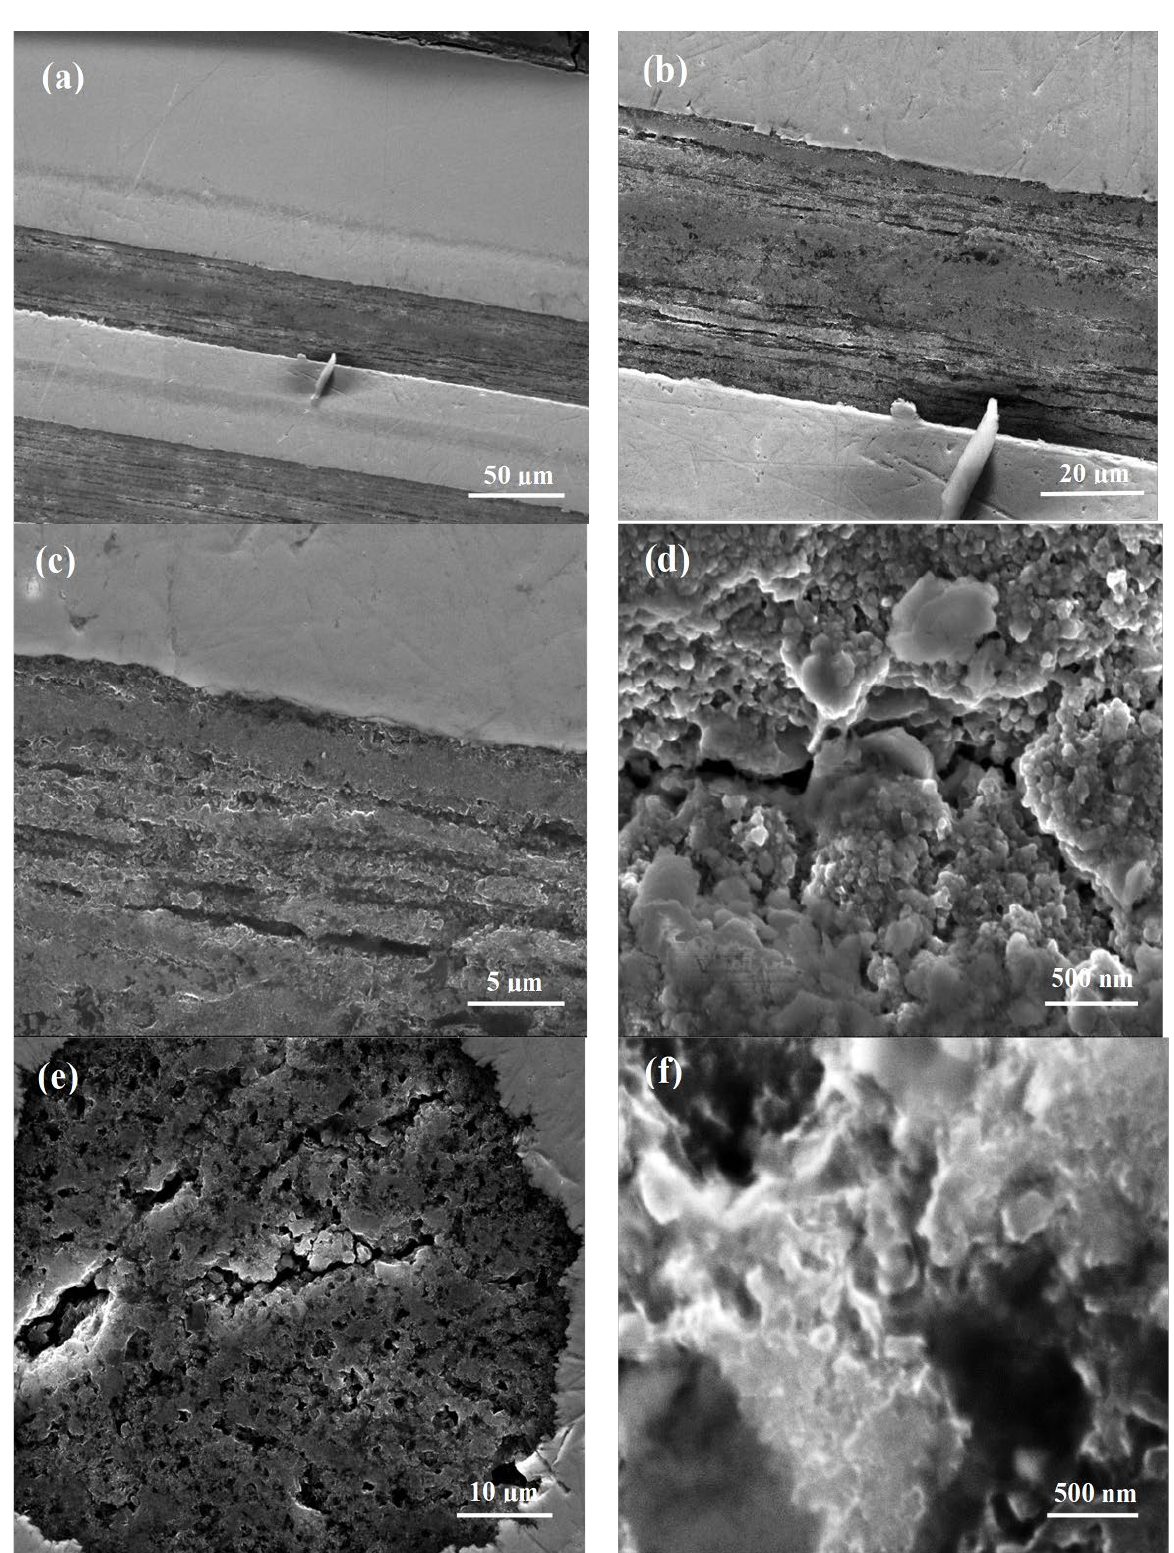
Figure 3. SEM photos ( a – d ) longitudinal-sections and ( e , f ) cross-sections for sample A annealed at 700 °C under isostatic pressure of 0.1 MPa for 15 min.